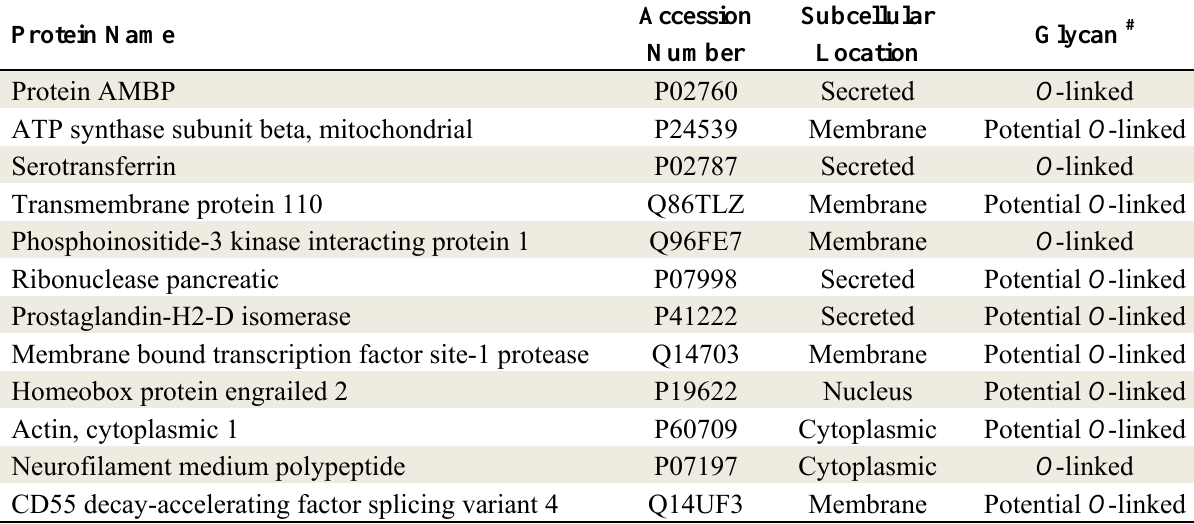
Table 4. List of O -glycosylated/potentially O -glycosylated proteins isolated using CGB